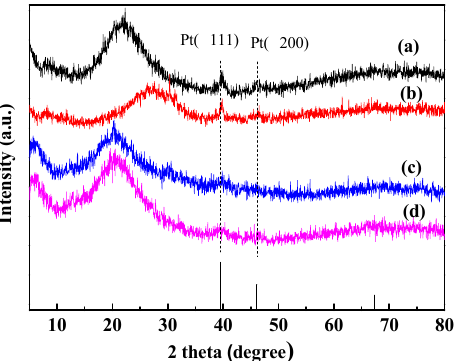
Figure 1. XRD patterns of Pt 0.5 /SiO 2 before ( a ) and after reaction ( b ), as well as Pt 0.5 /SiO 2 -Shiff before ( c ) and after reaction ( d ).